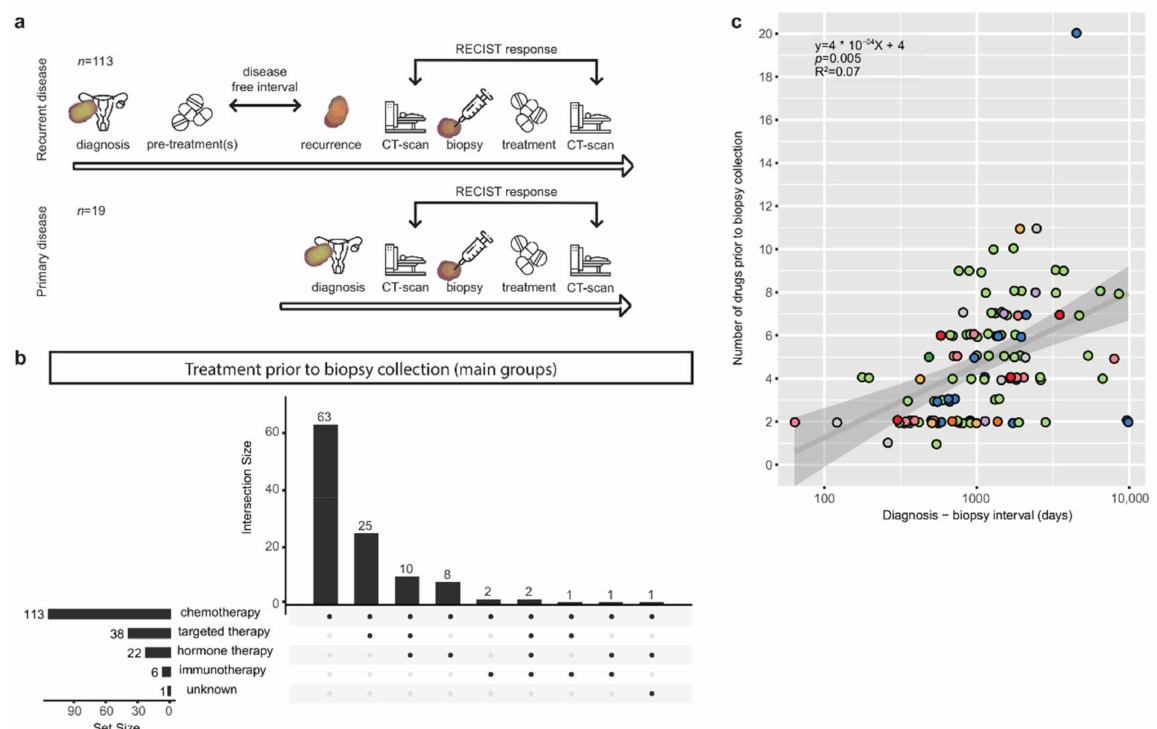
Figure 1. Study flowchart and treatment prior to biopsy. ( a ) Study timeline for biopsy samples ob- tained at recurrent disease ( top ) and primary disease ( bottom ). ( b ) UpSet plot with treatment history prior to the time of biopsy, categorized by treatment type, for samples that were obtained at recurrent disease ( n = 113). Horizontal bars (set size) indicate the number of patients that received a treatment type. Vertical bars (intersection size) indicate the number of patients that received a combination of treatment types. All patients with recurrent disease received chemotherapy. ( c ) Scatterplot with diagnosis-biopsy interval in days versus the number of drugs prior to the time of biopsy. NOS = not otherwise specified. A longer diagnosis-biopsy interval was correlated with was associated with a higher number of drugs ( p = 0.01, R 2 =